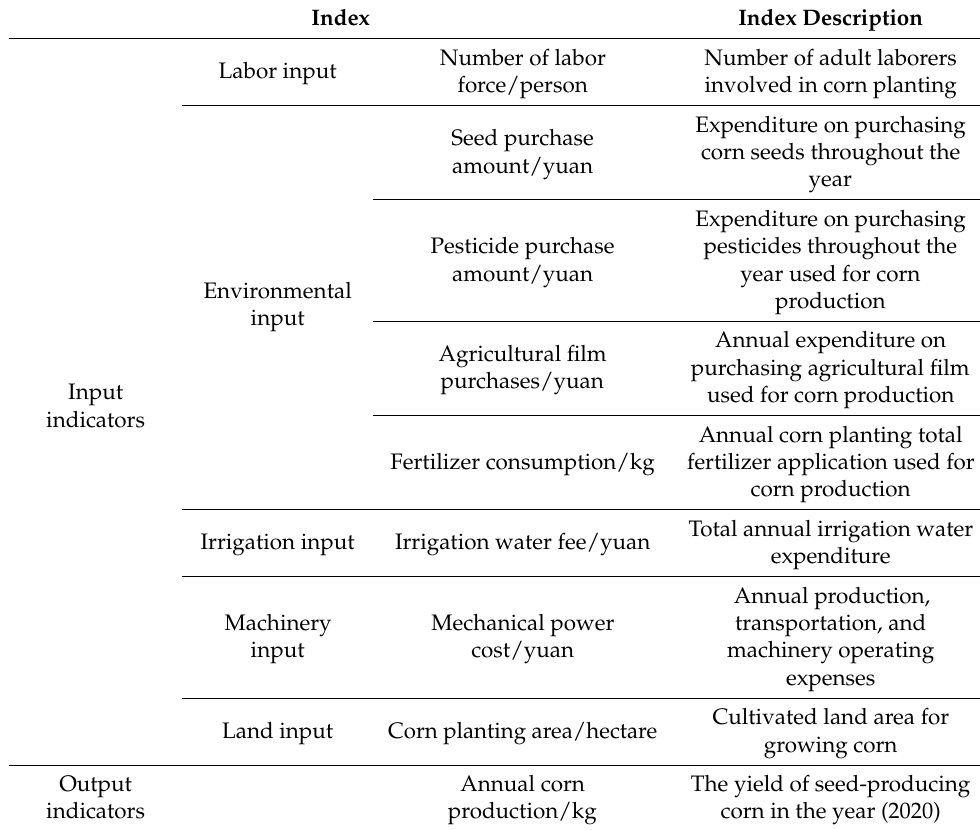
Table 1. Index selection and units for the input–output efficiency evaluation.